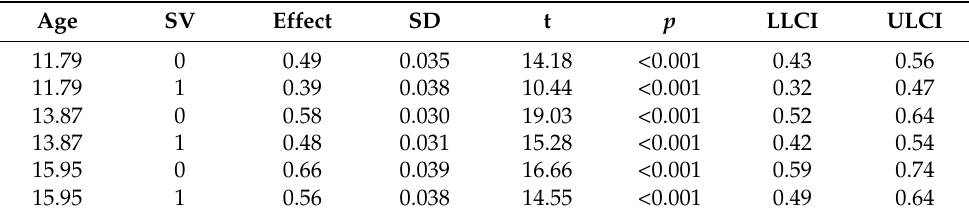
Table 7. Conditional effect of physical activity on subjective well-being, moderated by age and socioeconomic